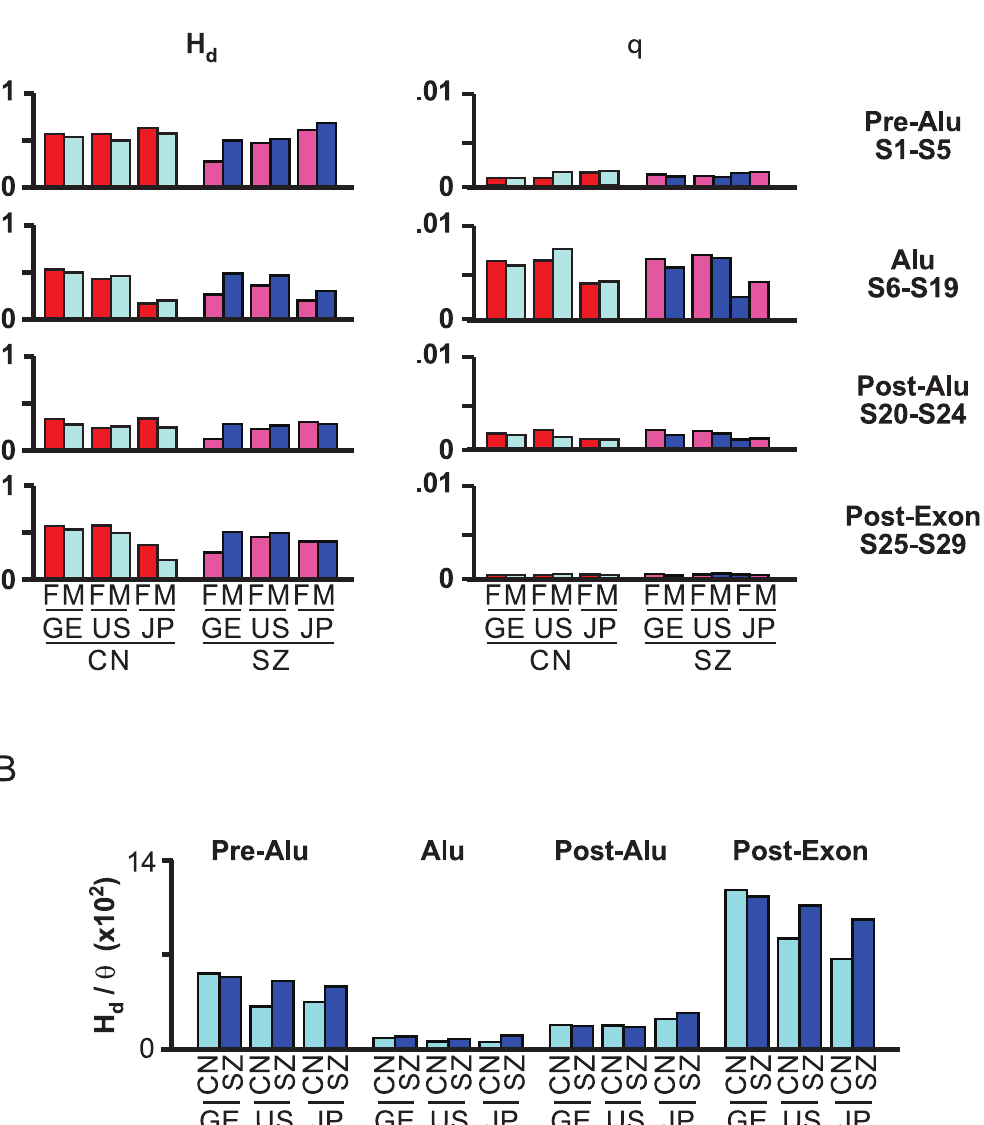
Figure 2. Sequence diversity in different sub-segments of S1–S29. (A) Sequence diversity profiles. Haplotype Diversity (H d ) and the mutation rate, Watterson’s Theta ( h ) were calculated for control males and females in GE, US and JP populations, and in the latter three for schizophrenic males and females (Table S1). (B) Recombination strength measured by H d / h for four SNP-containing sub-segments in S1–S29 sequence distinguished based on their positions relative to Alu Yi6AH-151 and Exon 9: Pre-Alu (S1–S5), Alu (S6–S19), Post-Alu (S20–S24) and Post-Exon (exonic synonymous S25 plus post-exonic S26–S29).